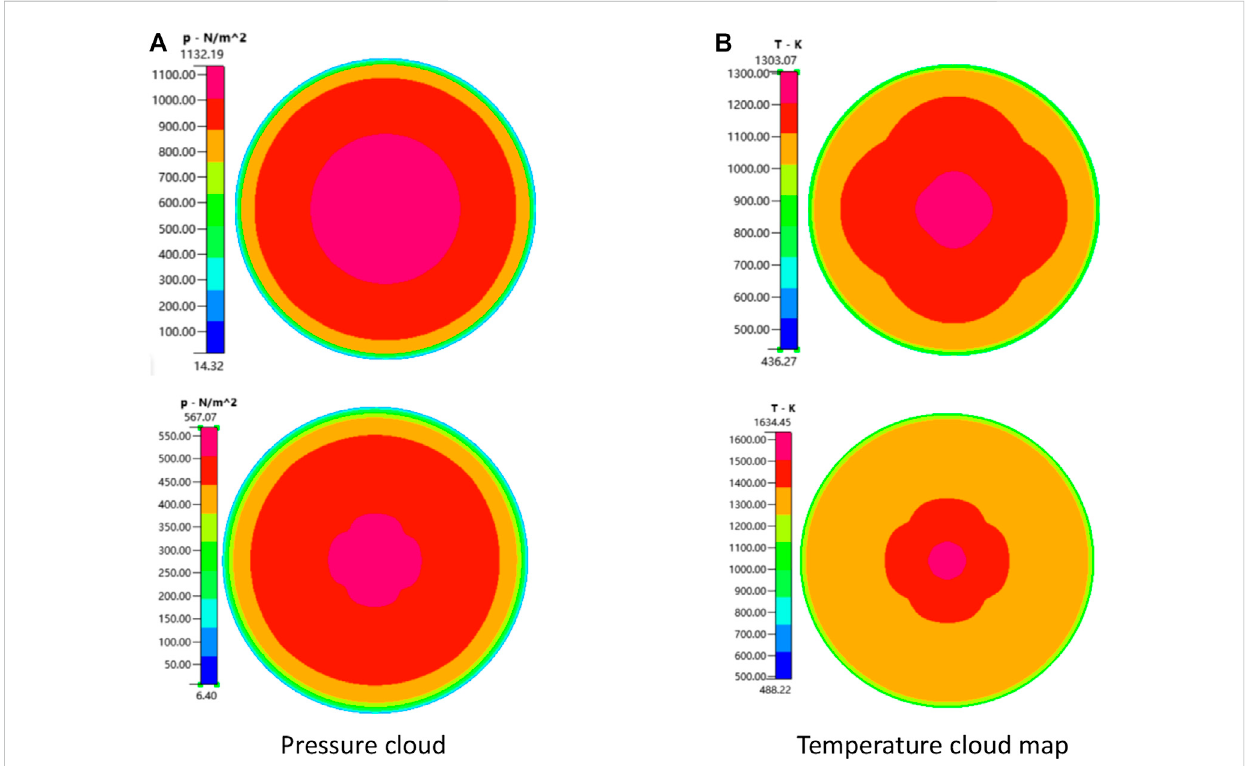
FIGURE 10 Cloud diagram of the pressure and temperature distribution on the windward side of the fl exible in fl atable structure. (A) Pressure cloud map (B) Temperature cloud map